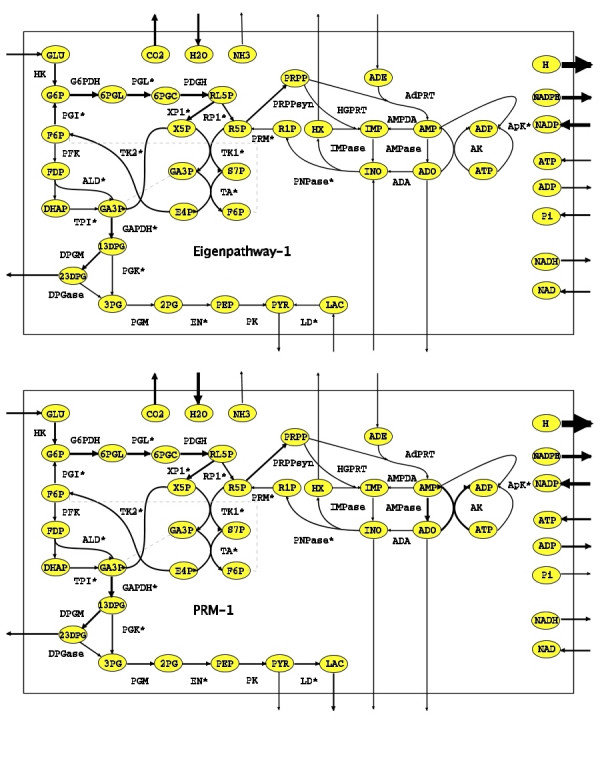
The first eigenpathway derived from SVD of the extreme pathways matrix and the first PRM derived from SVD of the samples matrix for the hRBC metabolic network. The relative values of the flux values is indicated by the thickness of the arrows between metabolites. The metabolite and reaction definitions are given in Table 1 and Table 2.